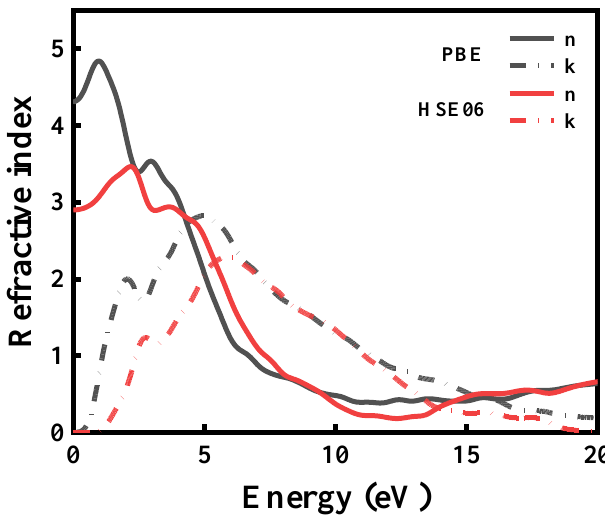
Figure 7. The complex refractive index of CdGeAs 2. The birefringence (Δ n ) of the CdGeAs 2 crystal calculated using the GGA–PBE and HSE06 methods is shown in Figure 8. The birefringence is expressed as the difference between two or three main refractive indices ( Δ𝑛 = 𝑛 𝑖 − 𝑛 𝑗 ) in heterogeneous bodies. The birefringence is an important physical quantity in measuring nonlinear crystal properties. The most suitable birefringence range of mid-infrared nonlinear optical crystal is 0.04 < Δ n < 0.1 [33]. According to Figure 8a, the static birefringence of CdGeAs 2 calculated using the GGA–PBE method is 0.11, which reaches the maximum value of 0.54 at 4.09 eV. As can be seen from Figure 8b, the static birefringence of CdGeAs 2 calculated using the HSE06 method is 0.08, which reaches the maximum value of 0.33 at 7.59 eV. At the wavelength of 10 μm, the experimental value of birefringence is 0.0864 [34]. The relative errors are 27.31% (GGA–PBE) and 7.41% (HSE06), so the result calculated by the HSE06 method is closer to the experimental value. By comparing the results calculated using the GGA–PBE and HSE06 methods, it is found that the bandgap of the CdGeAs 2 crystal is underestimated by the GGA–PBE method, which leads to the increase in the average static refractive index and birefringence in the mid-far infrared region.